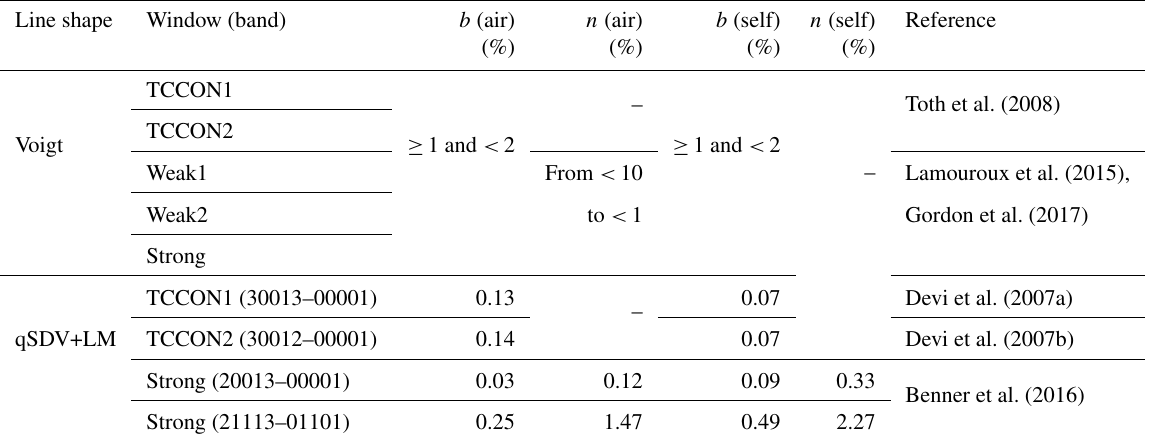
Table 4. The 1 σ relative errors of the air- and self-broadened Lorentz half-width coefficients ( b ) and of their temperature dependence ( n ). The values from Benner et al. (2016) and Devi et al. (2007a, b) use the median 1 σ uncertainty for the whole band, from the Appendix or supplemental files of these studies. The values for the Voigt line shape use the error codes reported in the HITRAN2016 line list (Gordon et al.,